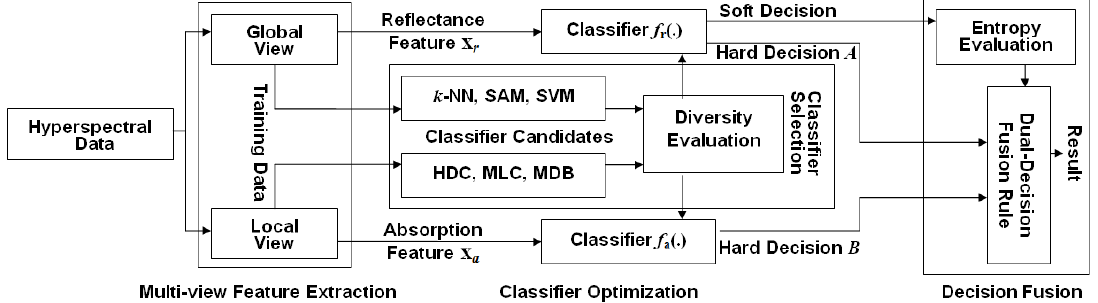
Figure 6. Fusion diagram for two sets of hyperspectral